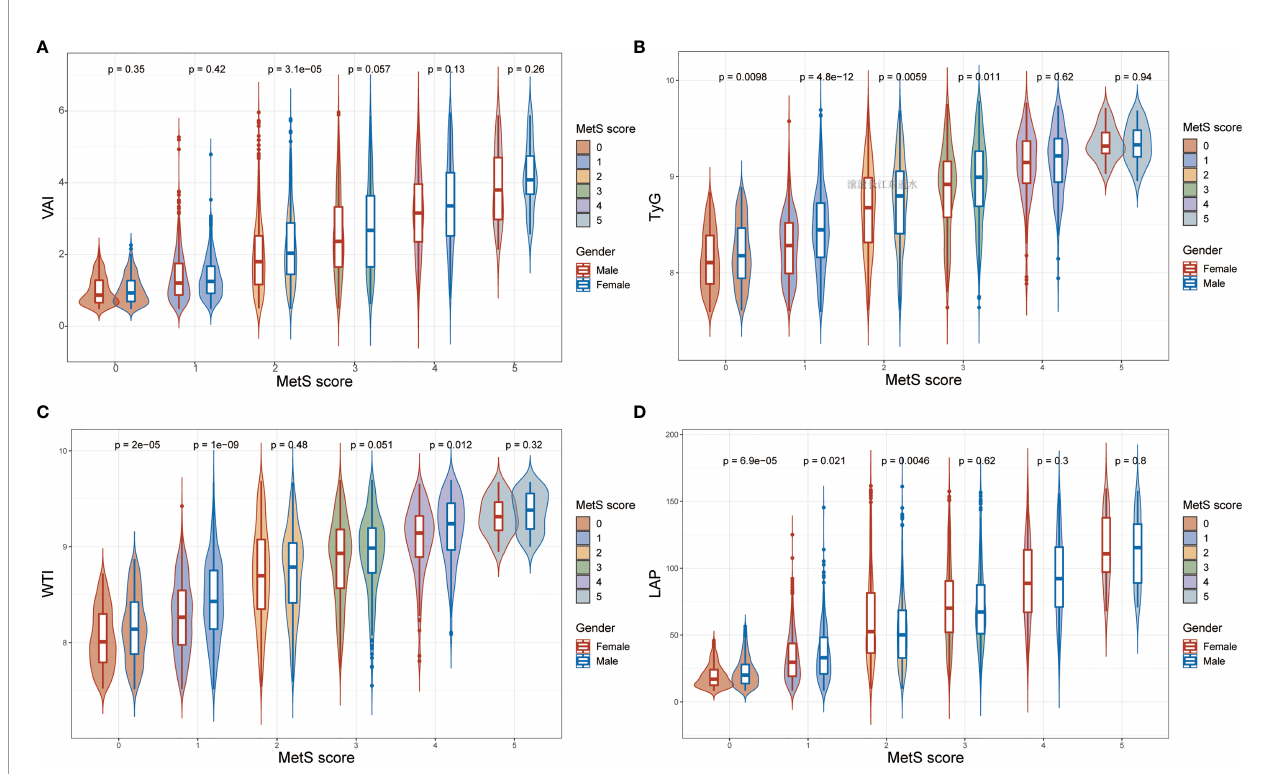
FIGURE 2 | The values of (A) visceral adiposity index (VAI), (B) triglycerides and glucose (TyG), (C) waist-triglyceride index and (D) lipid accumulation product (LAP) according to MetS components in both genders.